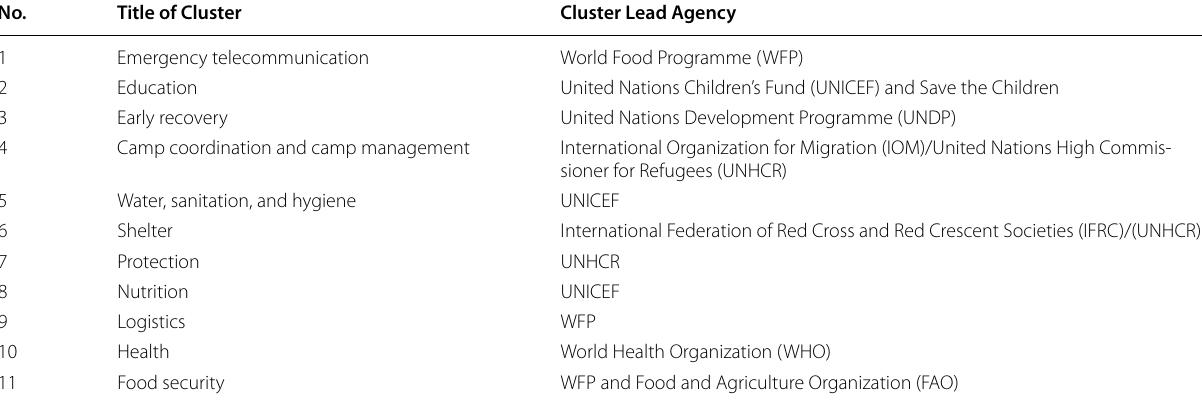
Table 1 Humanitarian clusters and their lead agencies, adapted from the IASC Cluster Coordination reference module (Inter Agency Standing Committee (IASC)